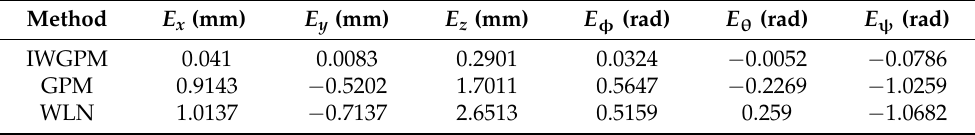
Table 2. The deviation of the EE between the actual pose and the desired pose at t = 10 s.